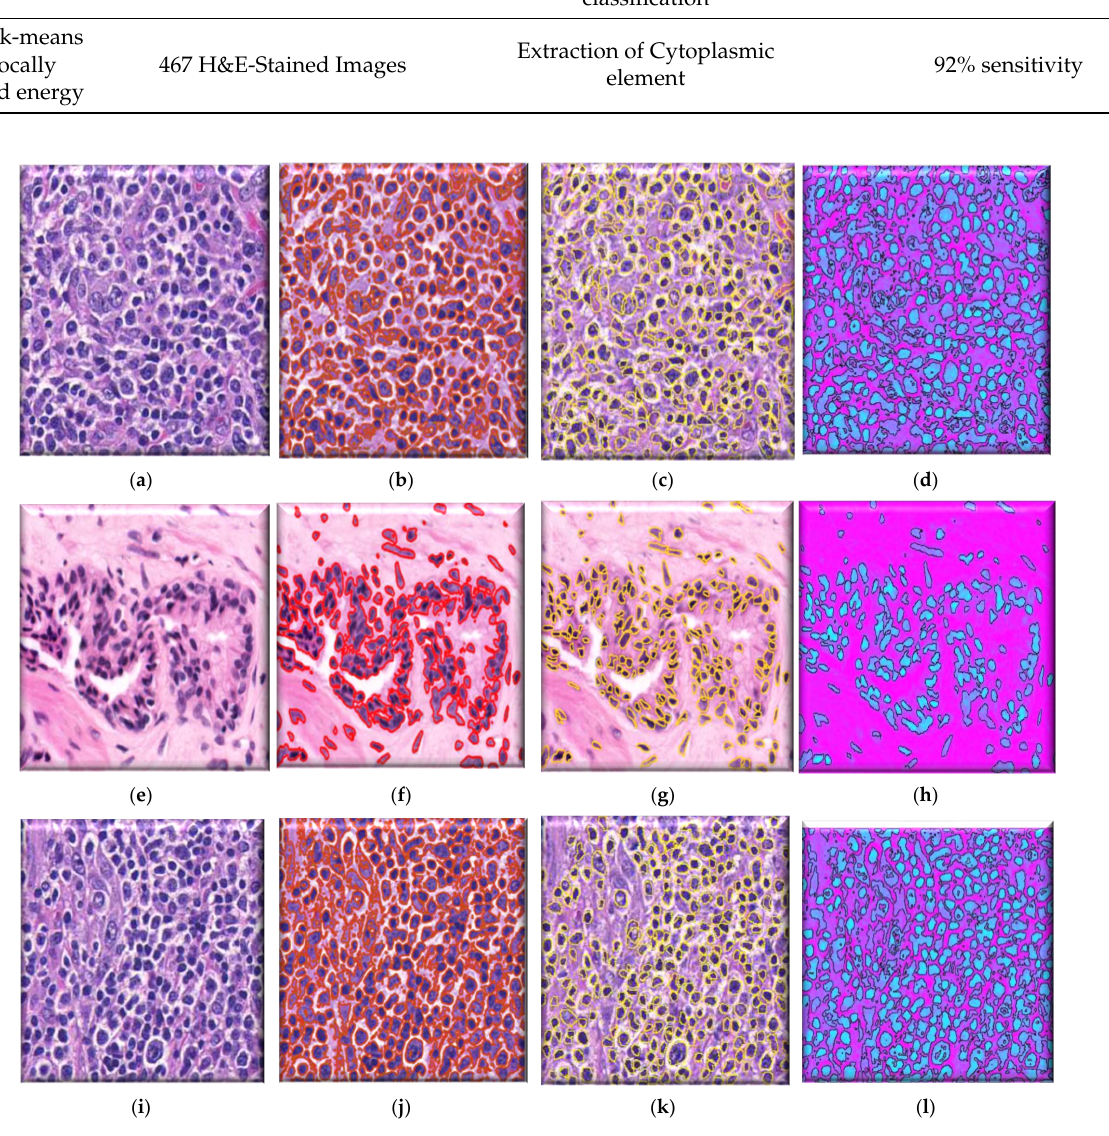
Figure 10. ( a , e , i ) Original prostate histological image ( b , f , j ) Segmentation results from GAC Model ( c , g , k ) Segmentation results from Madabhushi’s model and ( d , h , l ) Results from proposed local energy formulation model. Table 3. Quantitative evaluation of past research.